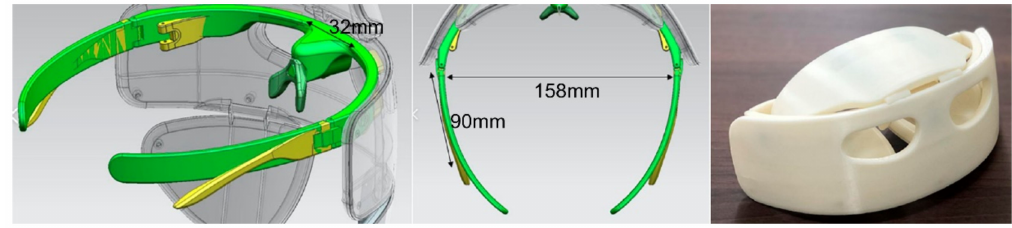
Figure 3. First LED-mask design